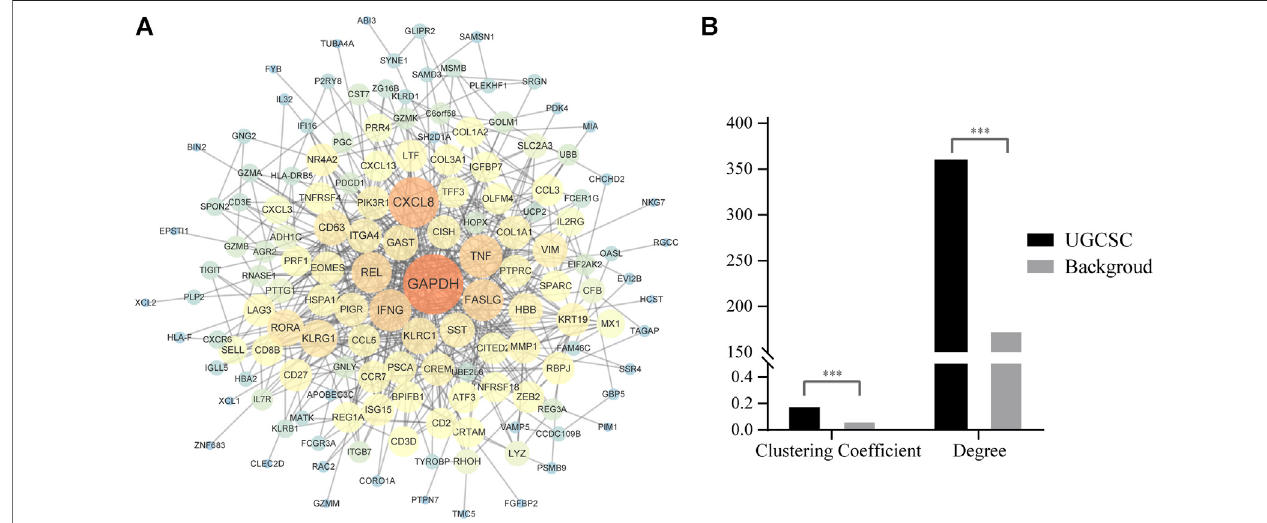
FIGURE5| NetworkanalysisofUGCSCs. (A) ProteinregulationnetworksofDEGsinUGCSCs. (B) TopologicalattributecomparisonofUGCSCsub-networksand whole PPIN.